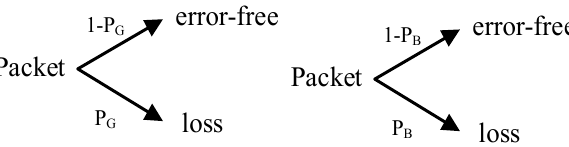
Figure 2. Probabilities of packet loss in different channel states.